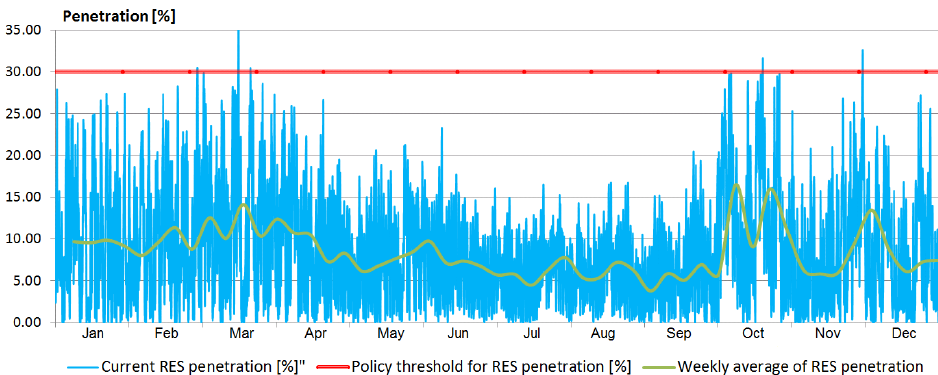
Figure 4. Current share of renewable energy sources (RES) in the final power consumption.